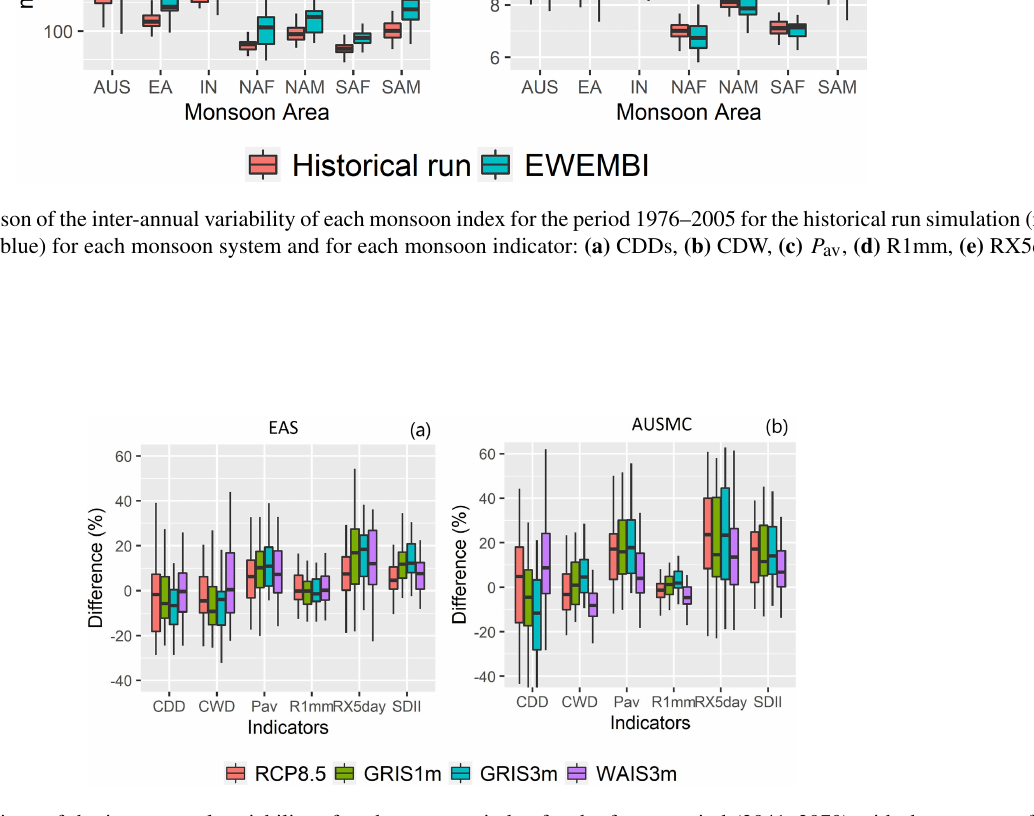
Figure C3. Comparison of the inter-annual variability of each monsoon index for the future period (2041–2070) with the average of the historical period (1976–2005) for each monsoon system: (a) EAS, (b)